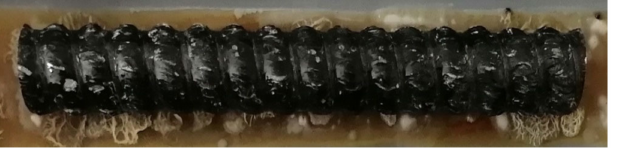
Figure 3. Picture of a typical fouling of BFRP No. 4 by colonies of Bacillus subtilis and Streptomyces albus in agar-based medium after 72 h. Scale